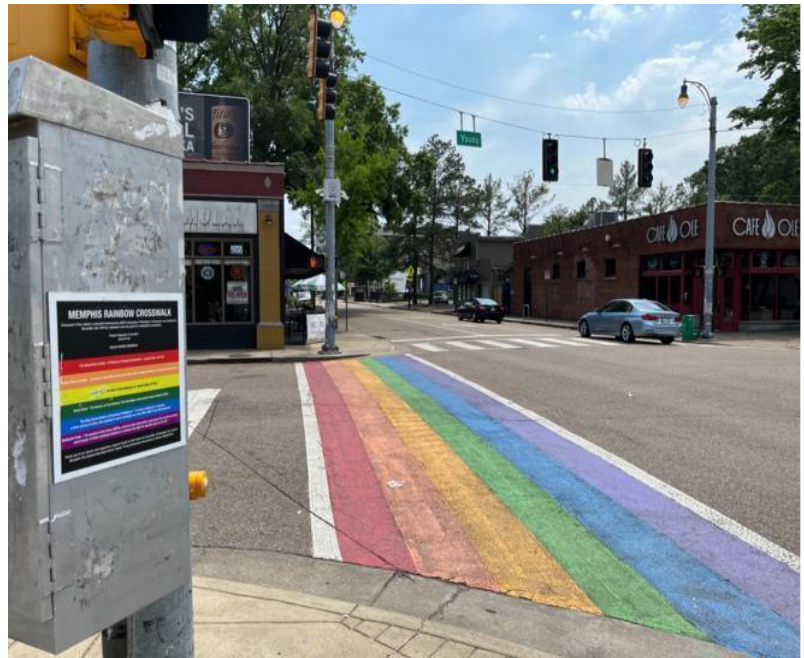
Figure 9. The LGBTQ+ symbolism extends to the neighborhood where Out Memphis is located and is exemplified by a rainbow crosswalk.